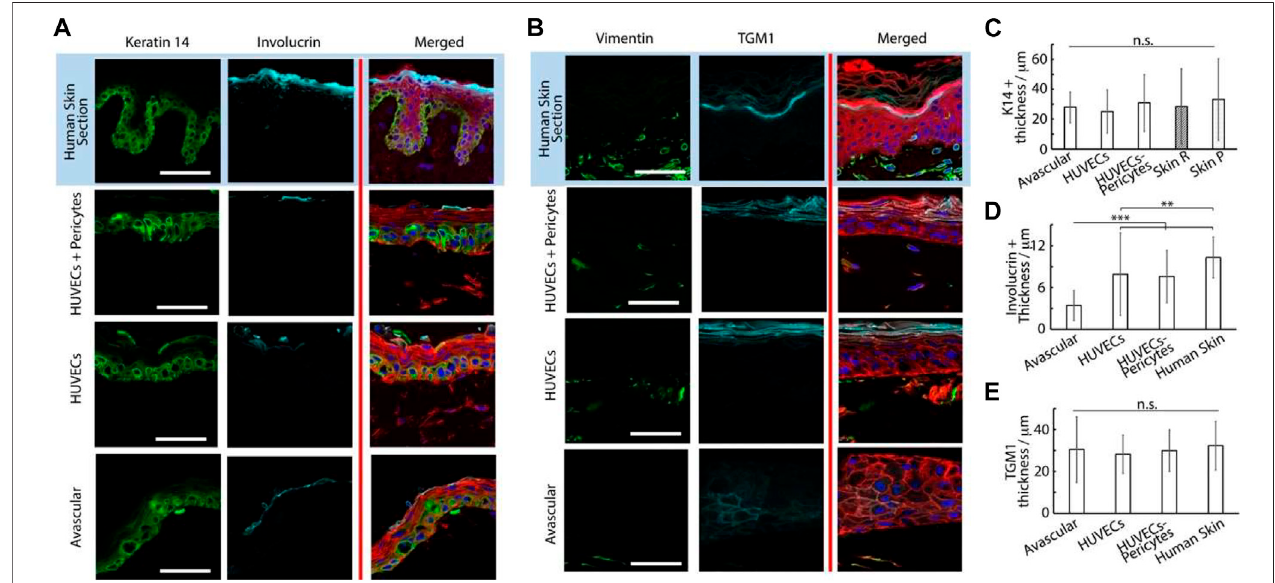
FIGURE 6 | Histology sections of microvascularized skin-on-chip constructs and human skin sections immuno-stained with phalloidin (red), DAPI (blue), and for K14andinvolucrin, (A) greenandcyan,respectivelyorvimentinandtransglutaminase, (B) greenandcyan,respectively.Tissueswereculturedfor14